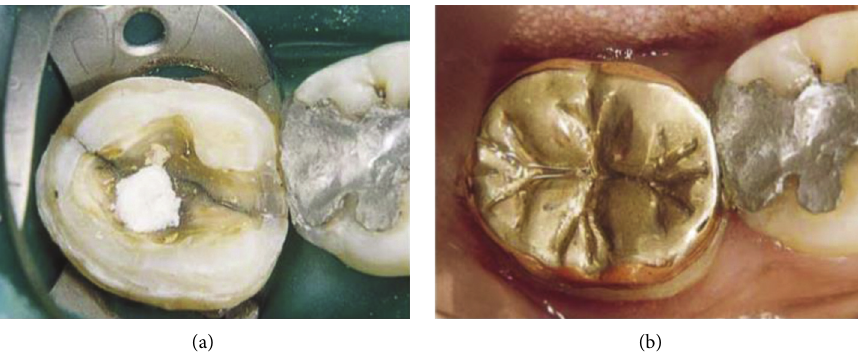
Figure 6: Restoration of a fractured right mandibular second molar using a gold onlay. (a) A cracked tooth prepared for restoration via onlay bonded with resin; (b) 22 months after restoration via bonded type III gold alloy inlays with Panavia Ex cement